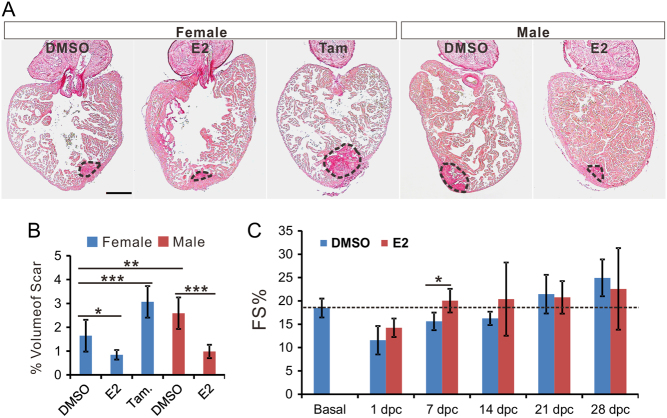
Estrogen accelerates scar reduction and promotes recovery of cardiac function. (A) Picrosirus red staining of the heart from female zebrafish treated with DMSO, E2 (1 nM) and tamoxifen (1 μM); and male zebrafish treated with DMSO and E2 (1 nM) at 30 dpc. Scale bar: 200 μm. (B) Quantification of scar volume from samples in panel A (marked by dash lines, mean ± s.d., n = 5~6). One-way ANOVA with LSD post hoc test, *P < 0.05, **P < 0.01, and ***P < 0.001. (C) Fractional shortening (FS) measured by echocardiography of male zebrafish before (basal) and at different time points during recovery in DMSO or E2 (1 nM) after CI. Two-way ANOVA with LSD post hoc test, *P < 0.05, n = 5~6.